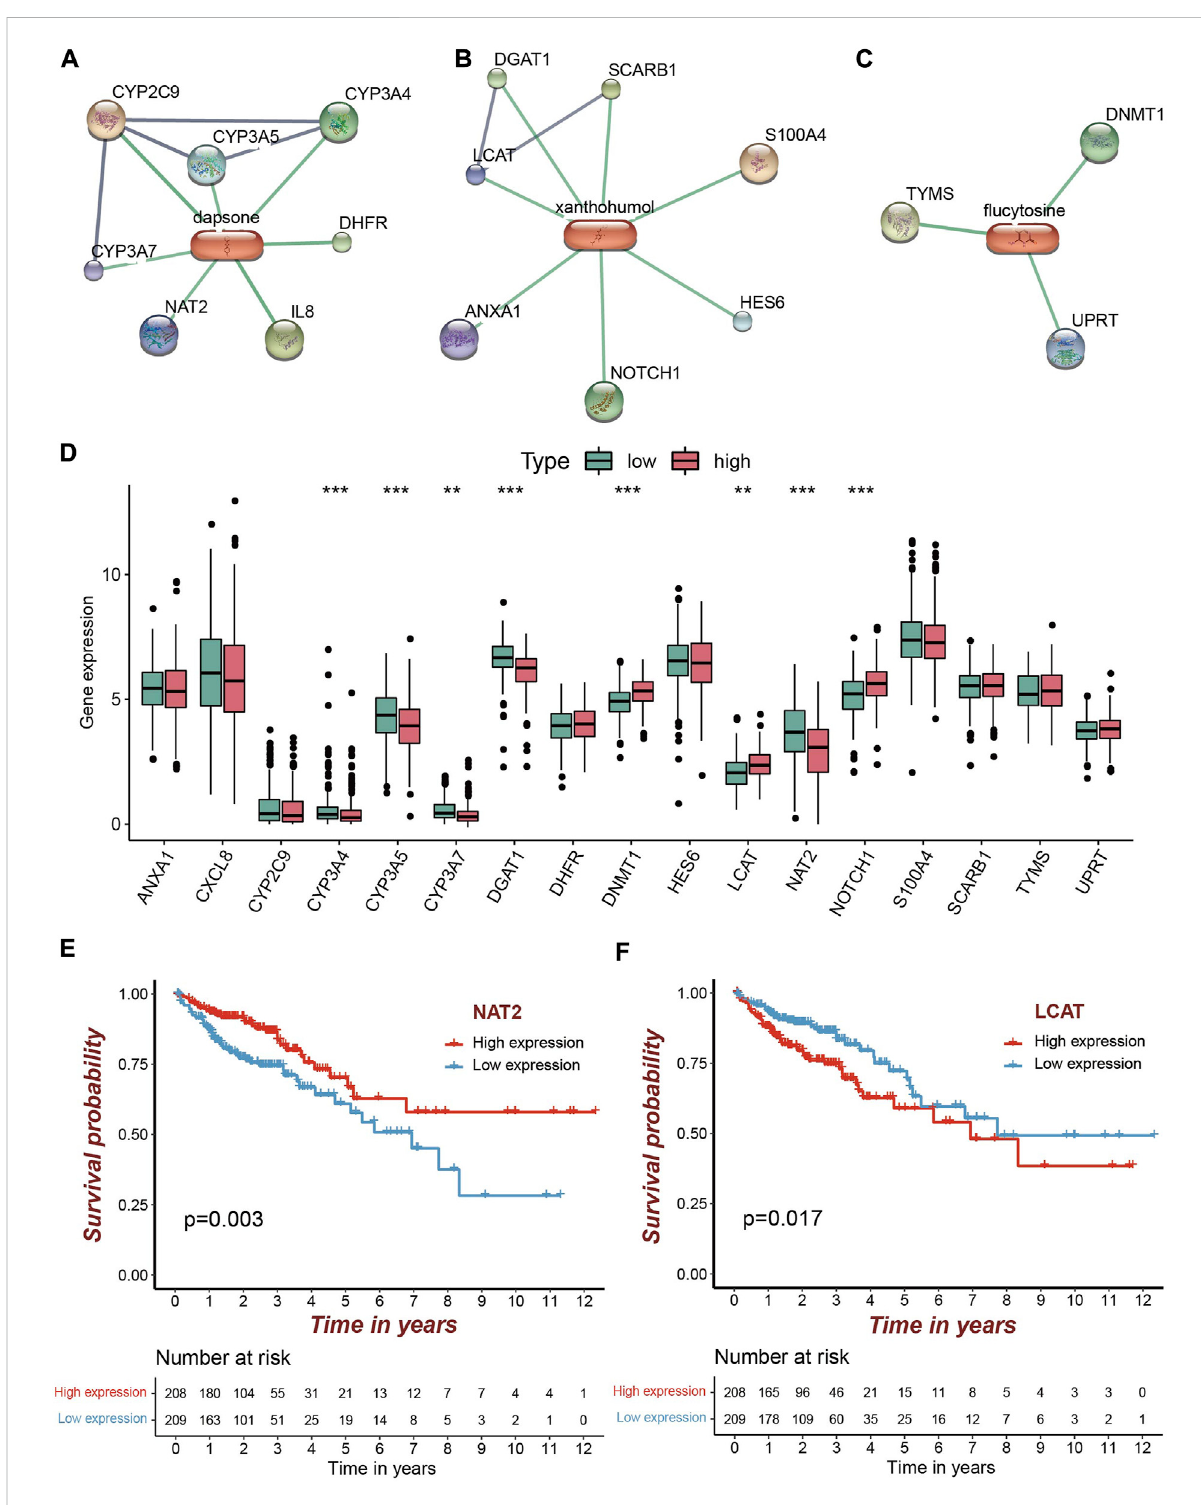
FIGURE 7 Candidate drugs screening for high risk patients and target identi fi cation. (A – C) The identi fi ed targets (con fi dence score > 0.8) from STRING for dapsone, xanthohumol and fl ucytosine, respectively. (D) Eight of the 17 targets were signi fi cantly differentially expressed, of which fi ve were signi fi cantly under-expressed in the high risk group and three were signi fi cantly over-expressed (** p < 0.01; *** p < 0.001). (E,F) Patients with a high NAT2 expression and patients with a low LCAT expression had a higher survival